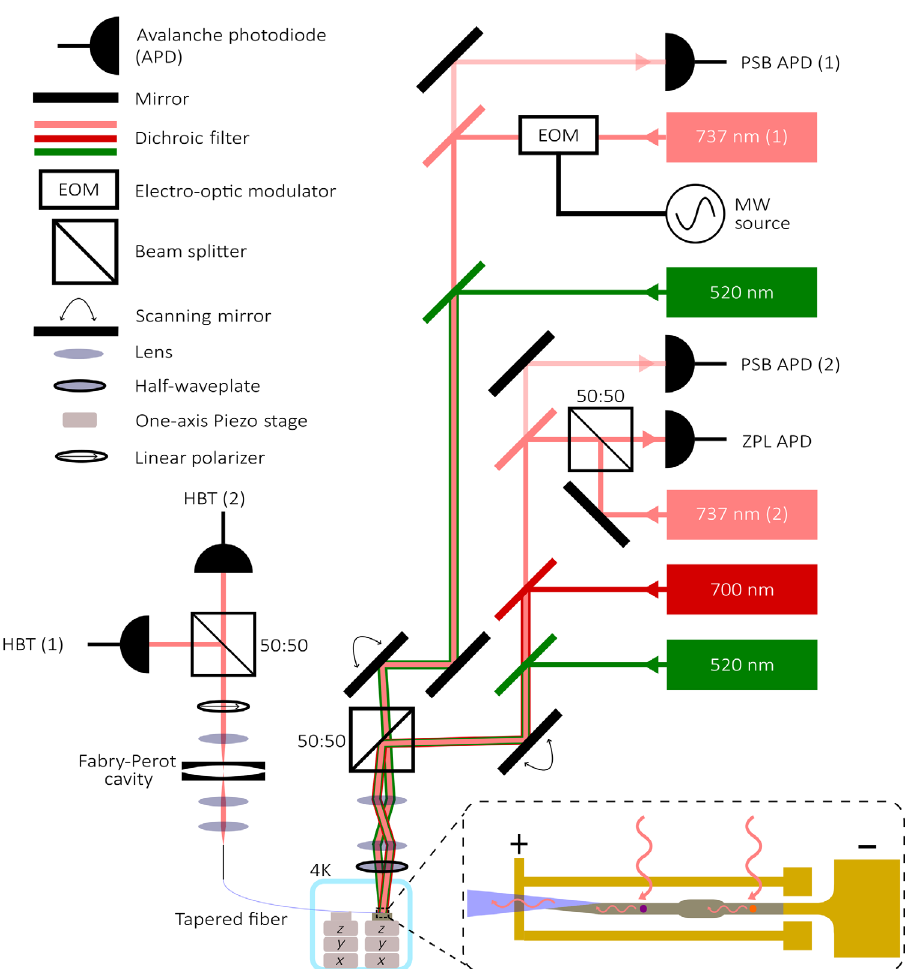
FIG. 6. Overview of the setup used in this